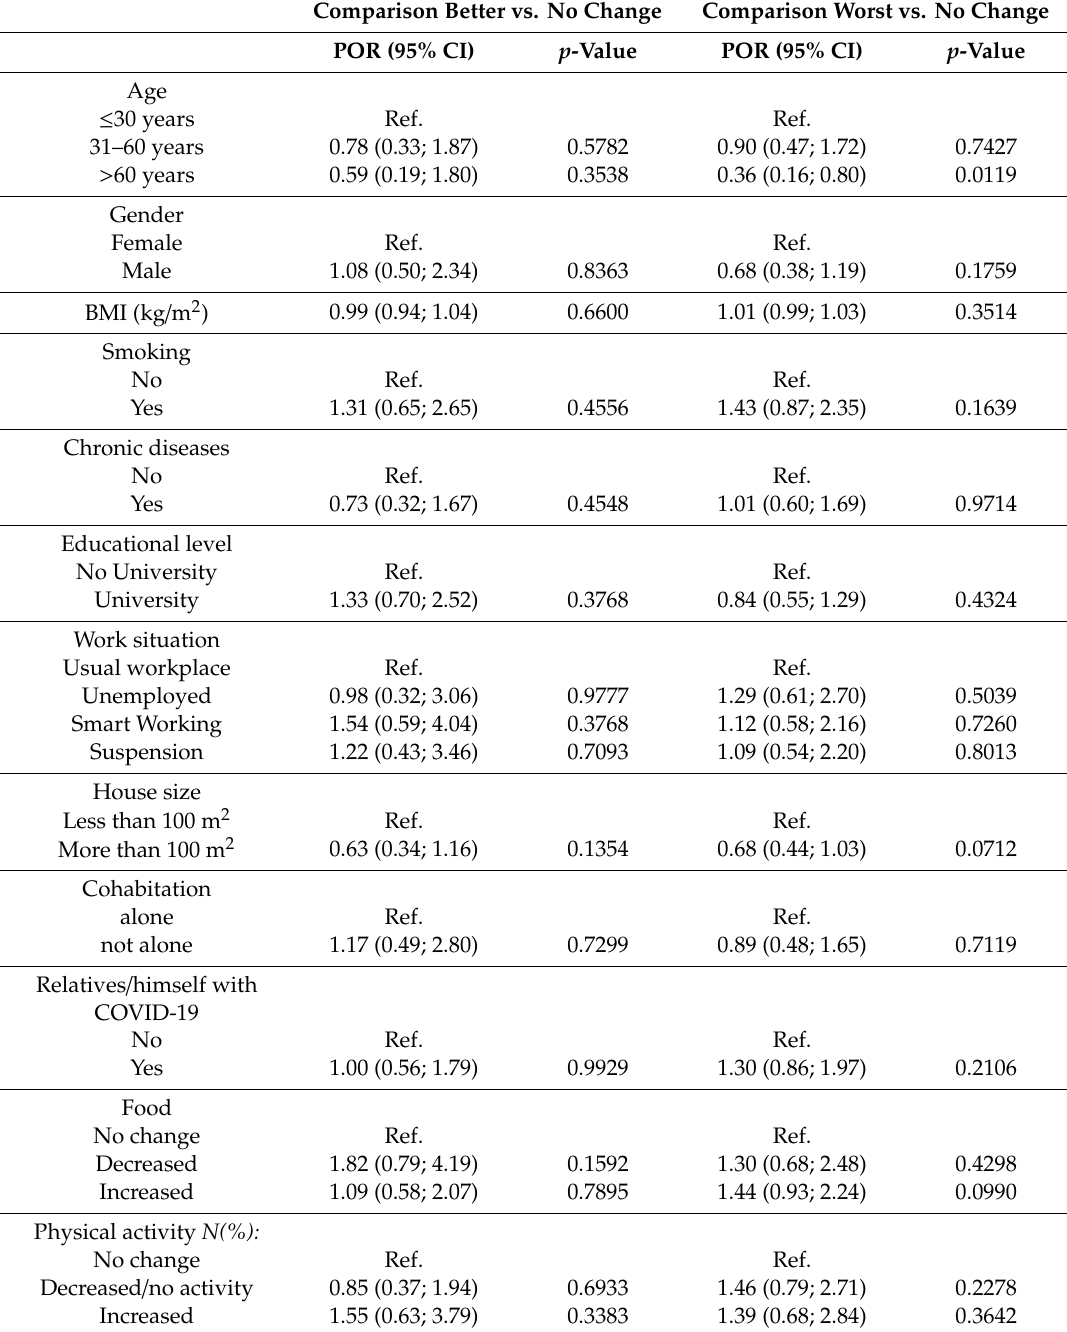
Table 2. Prevalence Odds Ratio (POR) for changes in the sleep quality. Comparison Better vs. No Change Comparison Worst vs. No